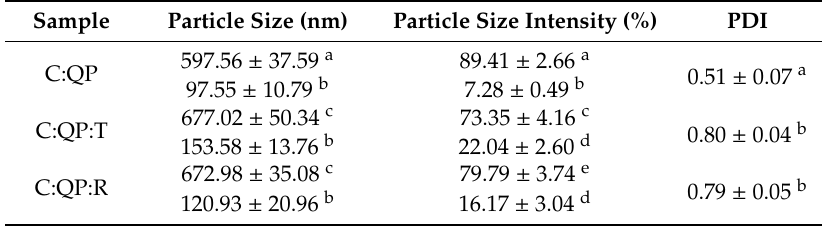
Table 2. Particle size and polydispersity index of filmogenic suspensions.